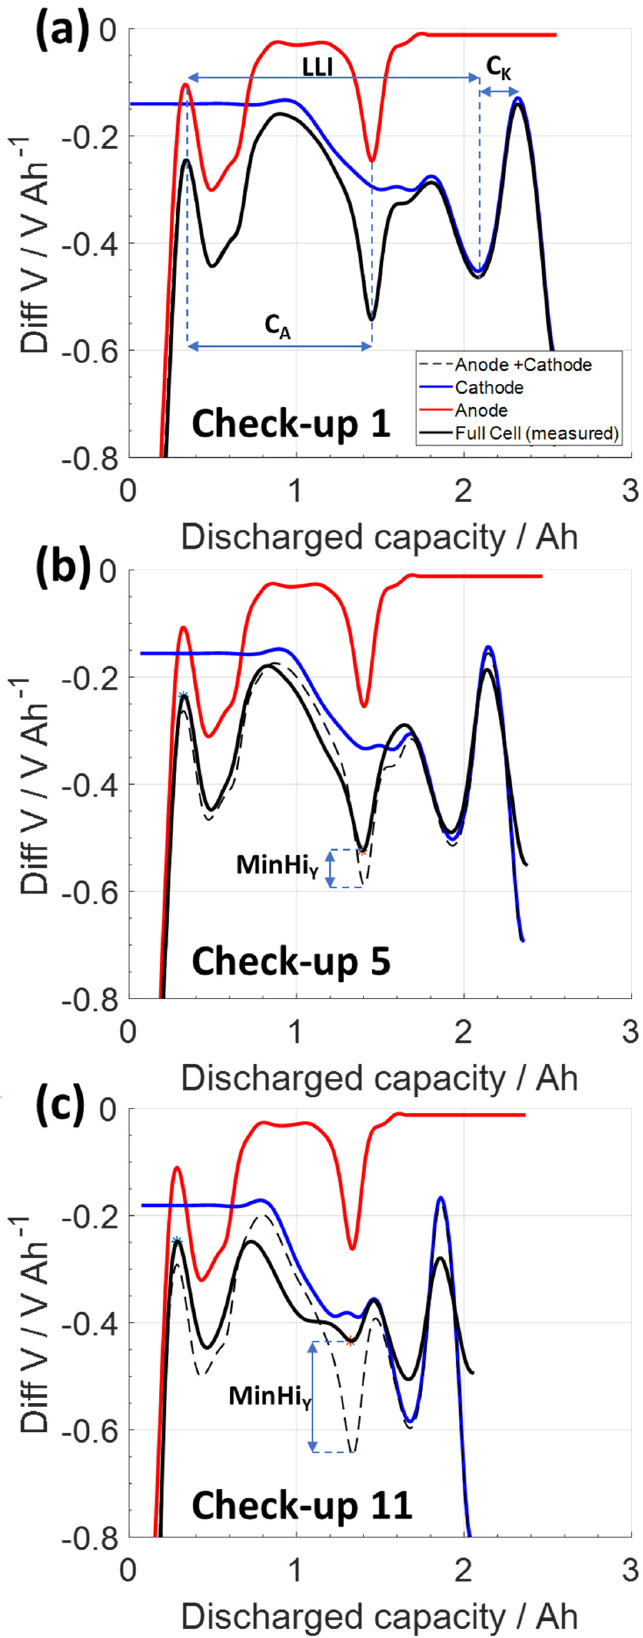
Figure 6. Exemplary dV/dQ-curve of the test cells to highlight the characteristic features of the anode and the cathode for three aging states measured at ( a ) check-up 1, ( b ) check-up 5 and ( c ) check-up